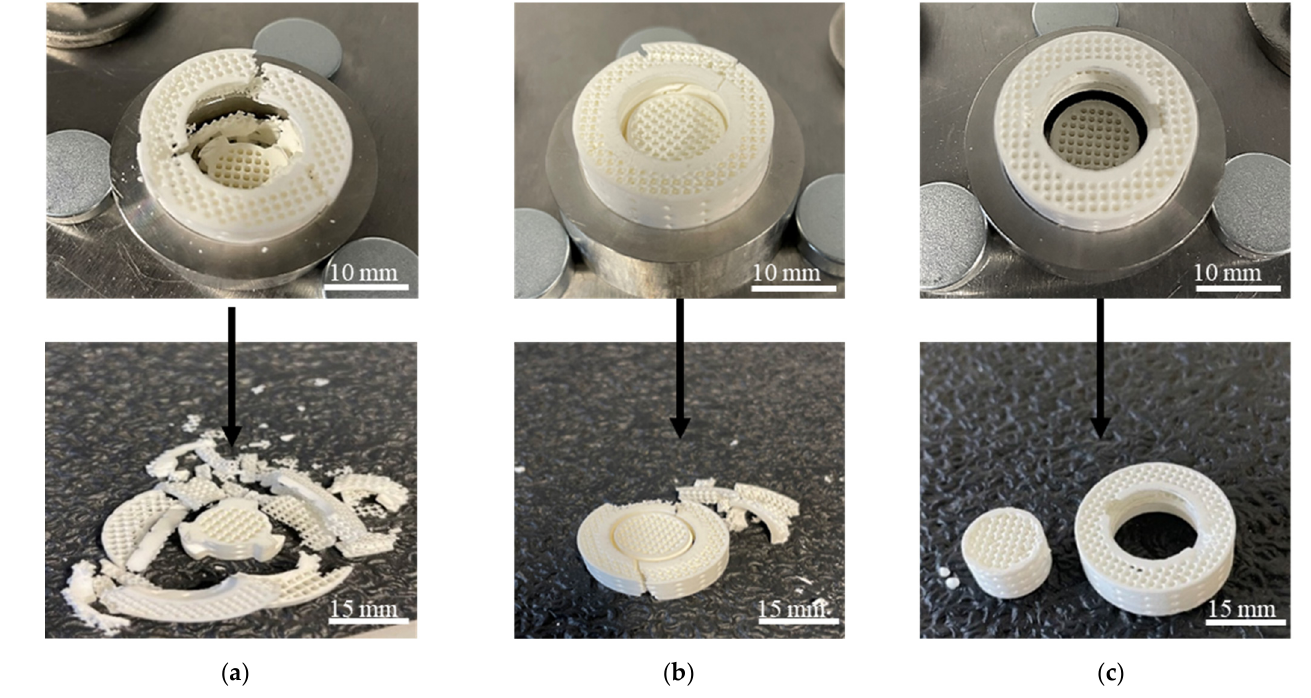
Figure 10. Deformation behaviour of ( a ) U-lock; ( b ) Thread; ( c ) Twist-lock.